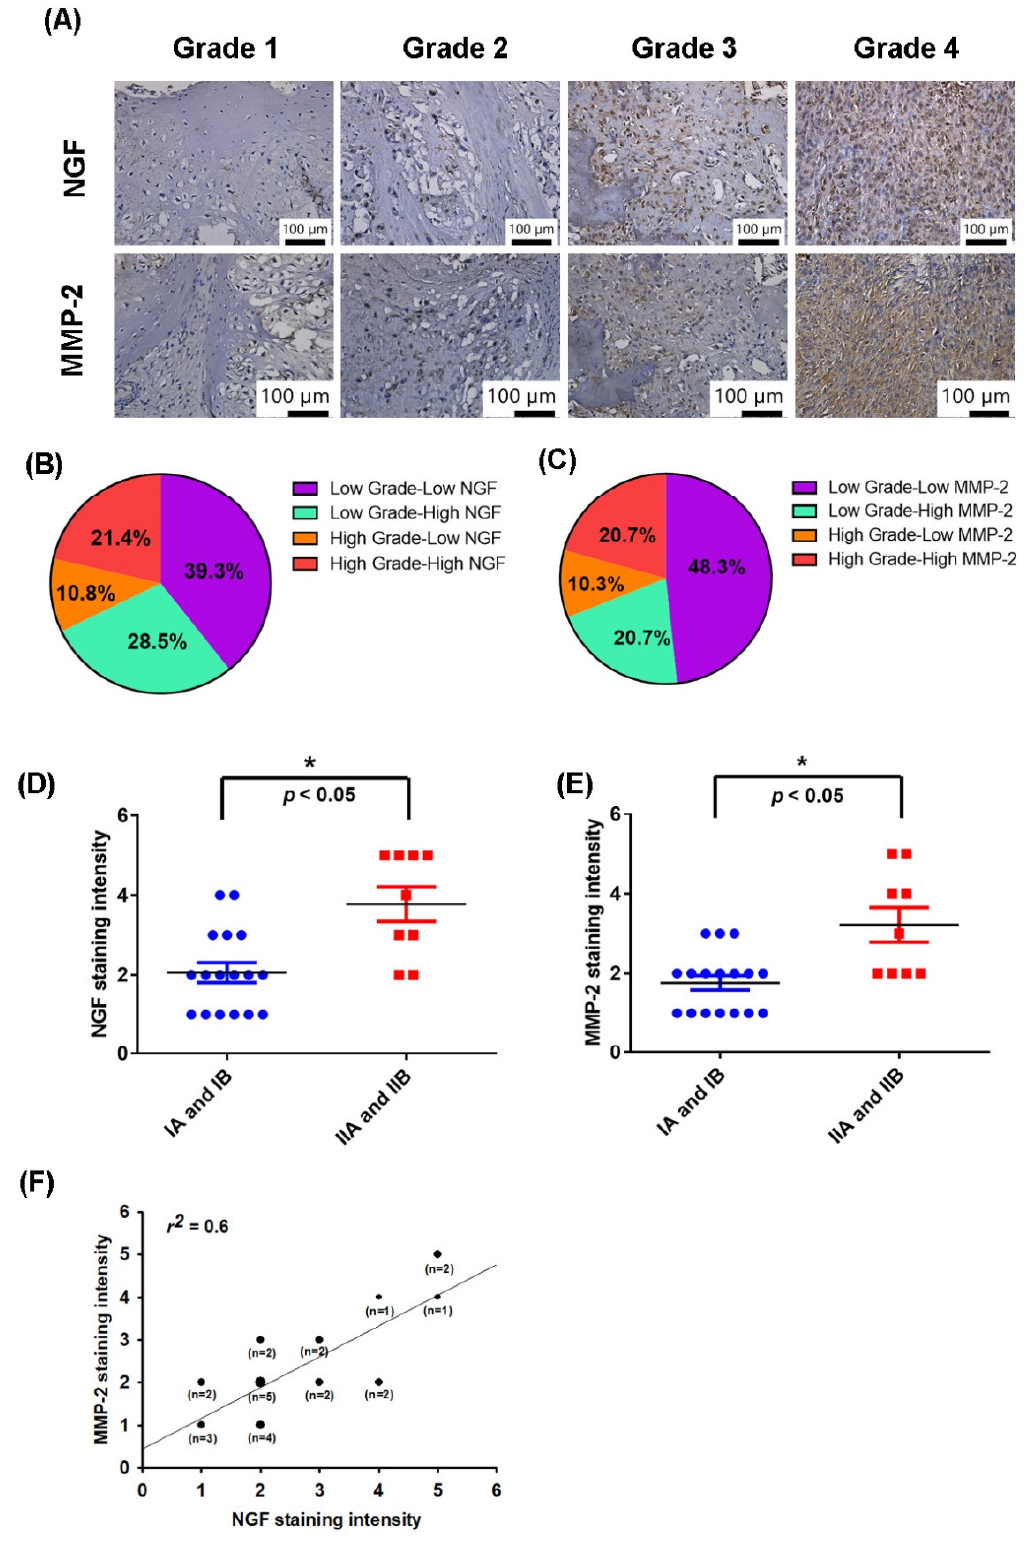
Figure 1. NGF and MMP-2 levels correlated with the chondrosarcoma tumor stage. ( A – E ) Immunohistochemistry (IHC)- stained tissue samples from chondrosarcoma patients were stained with NGF and MMP-2 antibodies then photographed and quantified. ( F ) Levels of NGF and MMP-2 were positively correlated. * p < 0.05 compared with the early stage (IA and IB) tumor group.